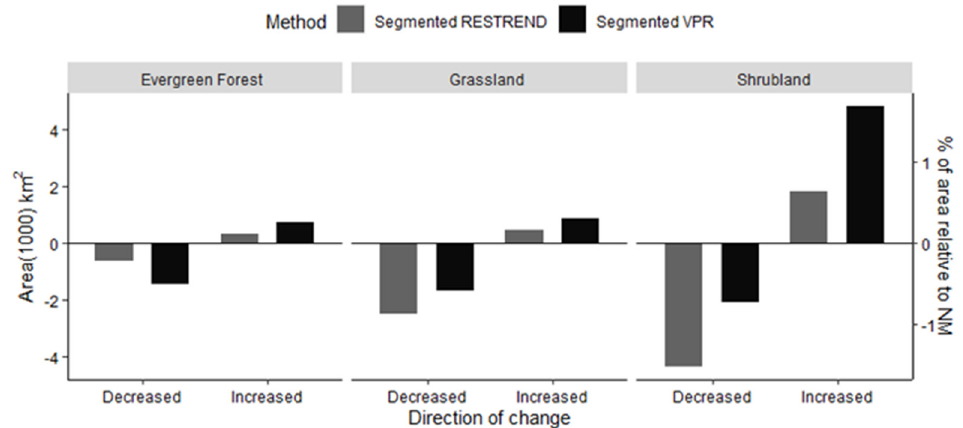
Figure 7. Area and direction of change in productivity in grasslands, shrublands, and evergreen forests in New Mexico as identified using the Segmented VPR (degraded vegetation or gradual increase) and Segmented RESTREND (reversal and initiation of degradation) methods.